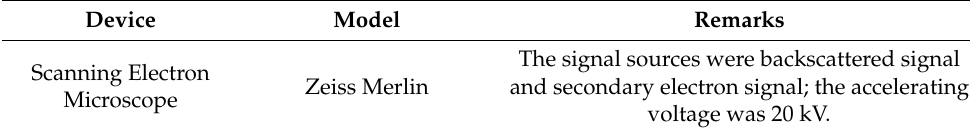
Table 5. The device